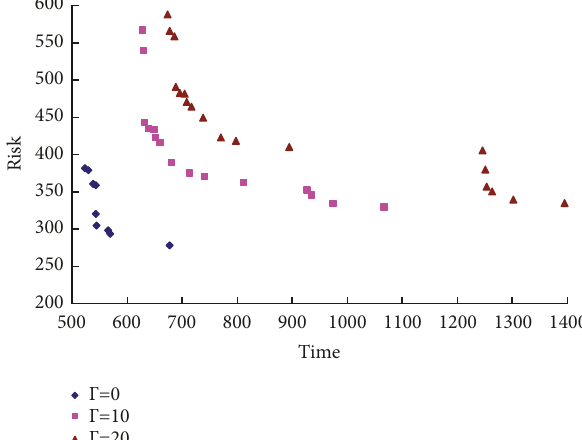
Figure 6: Pareto optimal solution distribution of robust control parameters Γ =0, Γ =10, and Γ =20 for distribution center